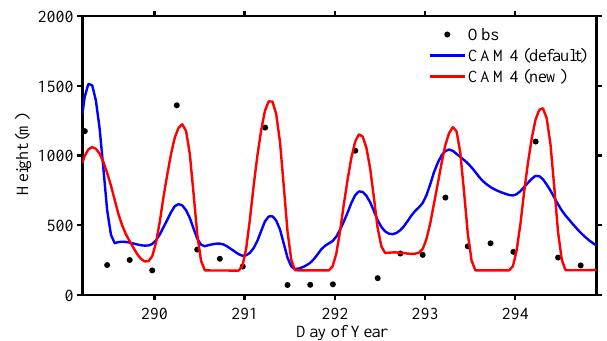
Figure 13. Comparison of observed and simulated PBLHs using CAM4 with the default and new Ri bc values during the period 16–21 October 2008 at the ARM